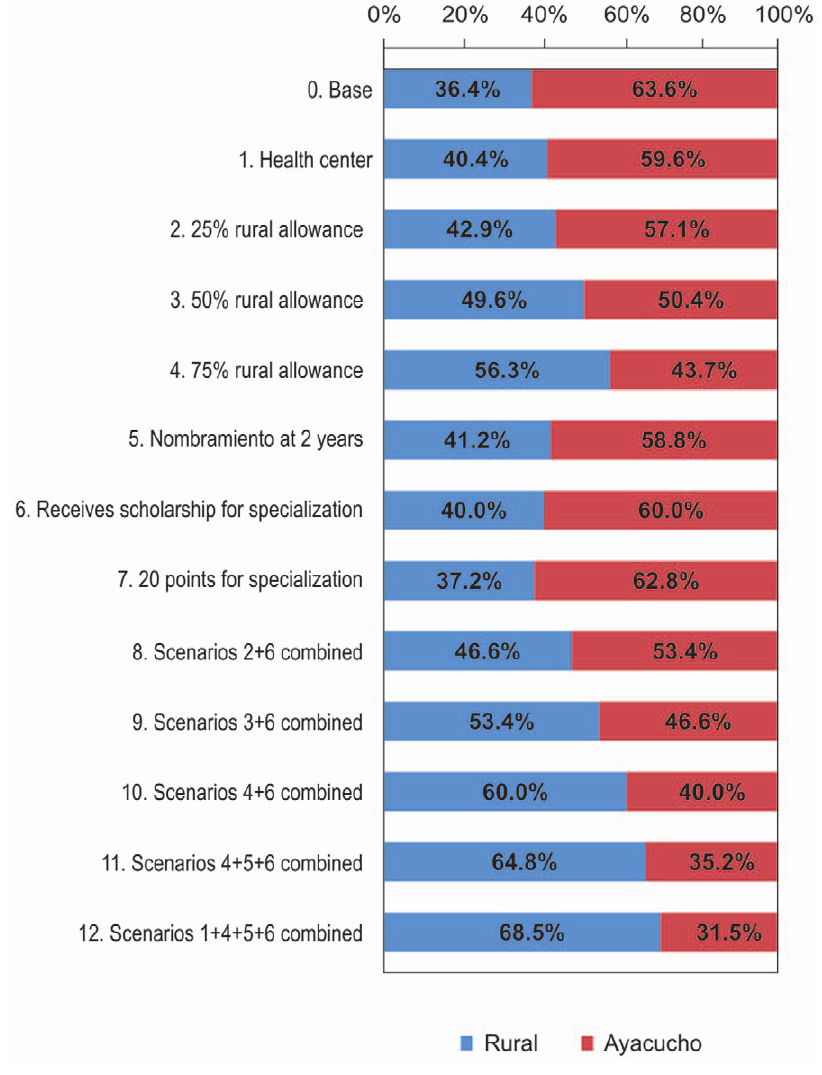
Figure 1. Policy simulations showing changes in proportion of health workers opting for a rural job when individual or combined incentives are offered, relative to base scenario*. *The scenarios correspond to simulations, when individual or combined incentives could be offered, relative to baseline scenario and using the coefficients of each specific attribute studied.